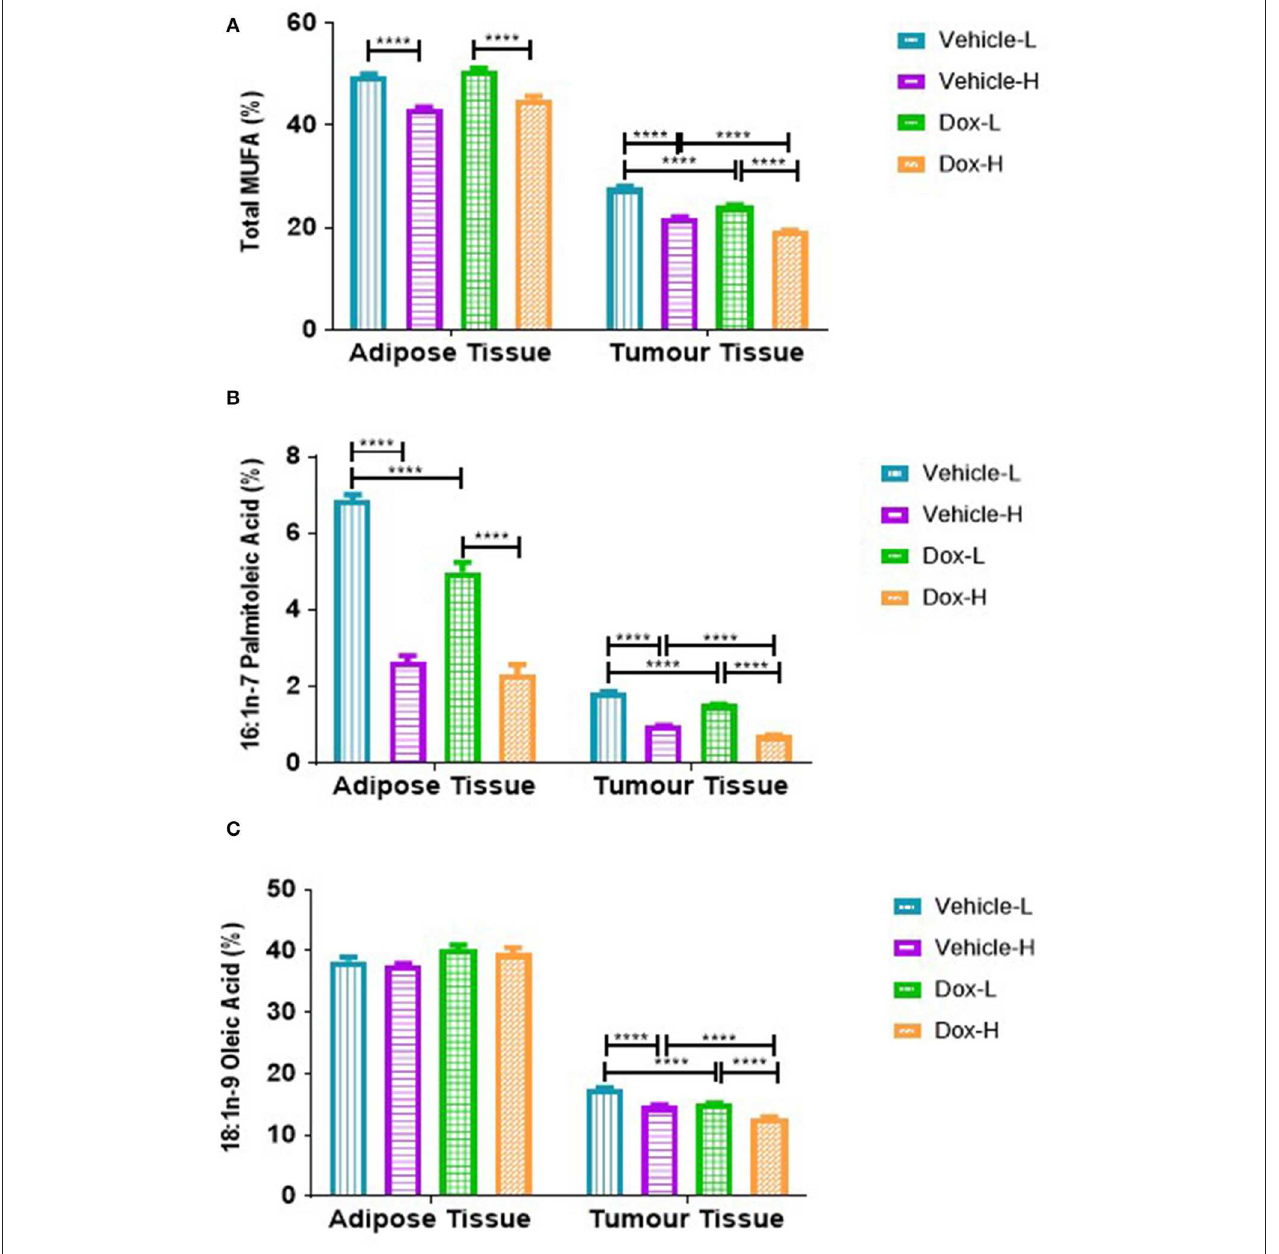
FIGURE 10 | Monounsaturated fatty acid composition; (A) Total MUFAs, (B) Palmitoleic Acid and (C) Oleic acid of mammary adipose- and tumor tissue of mice fed a LFD or HFD diet with either vehicle control or doxorubicin treatment. Results are presented as mean ± SEM ( n = 5). Two-way ANOVA with Fisher’s LSD post hoc correction was applied and p < 0.05 was considered as statistically significant. **** p <